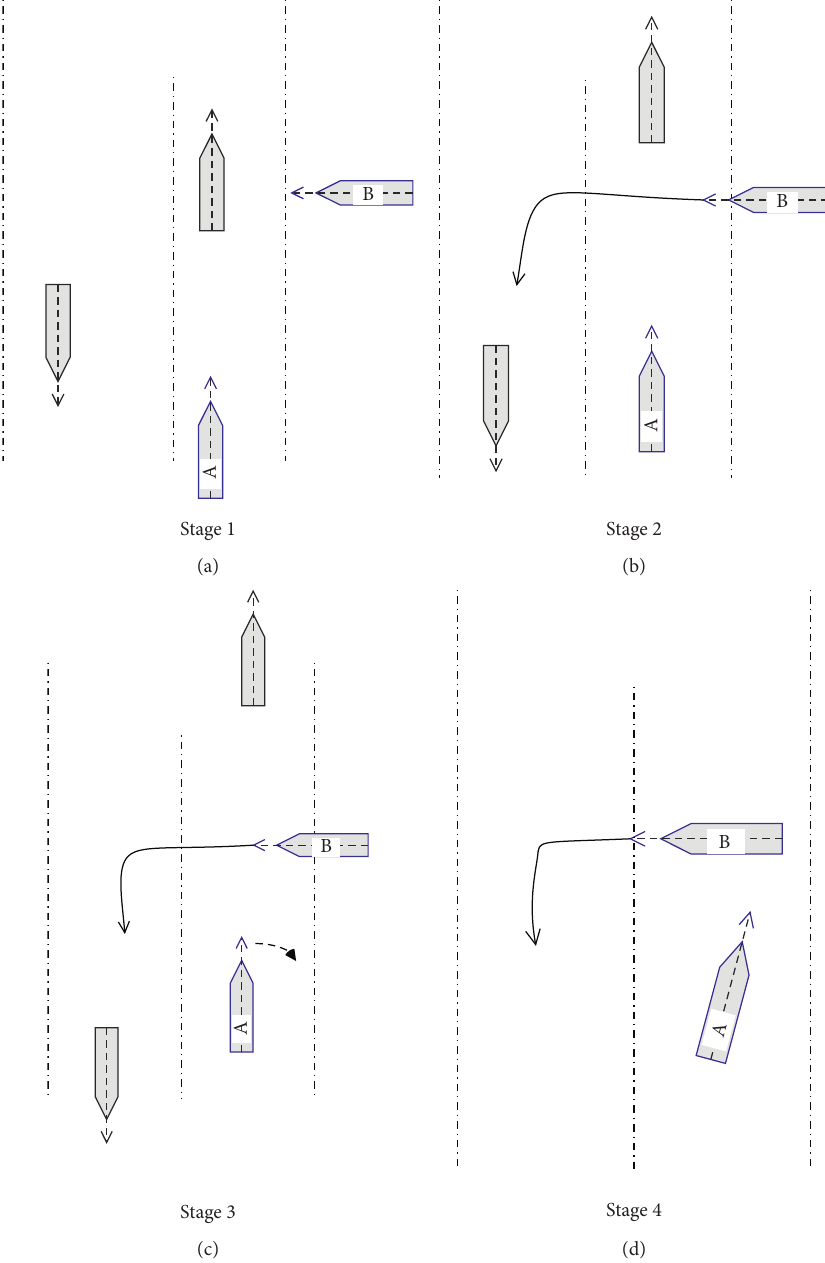
Figure 14: Stages of collision-avoidance in a narrow waterway of the Yangtze River. Stage one: the two vessels have not yet understood each other’s movements. Stage two: the vessels have not yet unified their collision-avoidance strategies. Stage three: the vessels have not yet taken coordinated maneuvering actions. Stage four: the vessels have to verify collision-avoidance